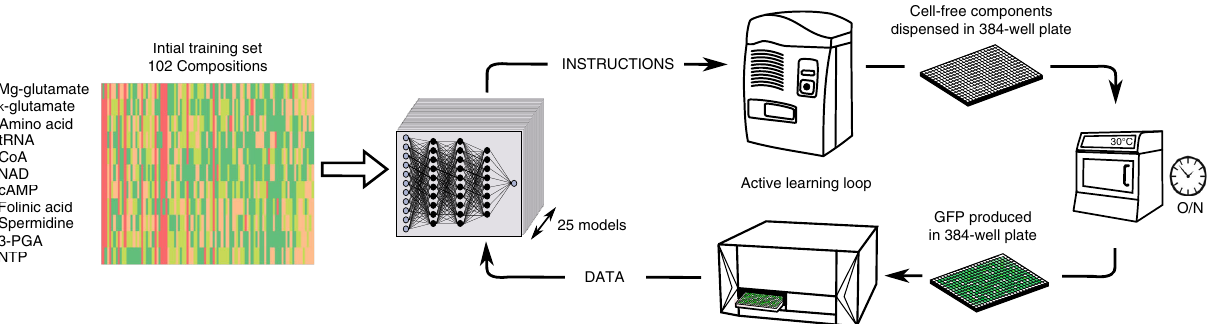
Fig. 2 Active learning loop to explore the buffer composition of a cell-free system. Illustration of the active learning approach used to explore the combinatorial space of cell-free composition and trained an ensemble of 25 machine learning models. Source data are provided in the Source Data fi le.